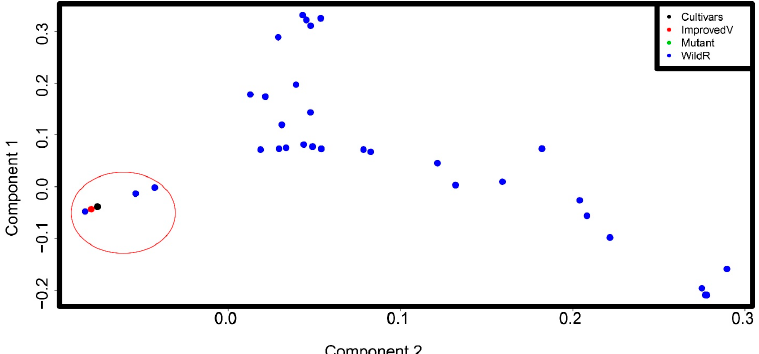
Figure 2. Principal component analysis (PCA) plots of the first two eigenvectors for the Eragrostis